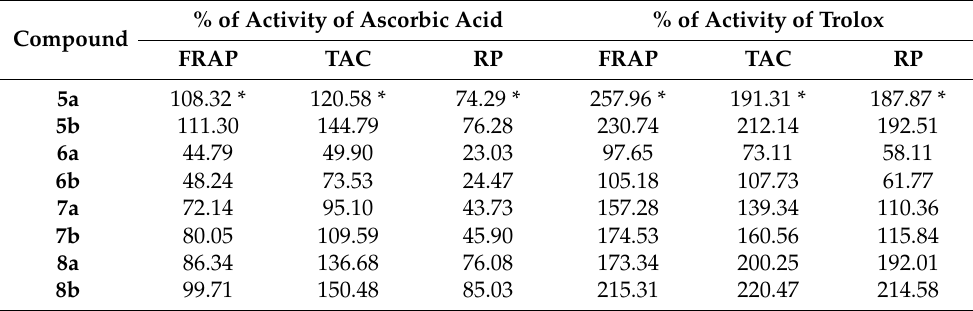
Table 4. Results of the Ferric Reducing Antioxidant Potential (FRAP), Total Antioxidant Capacity (TAC), and Reducing Power (RP) assays, expressed as % activity of ascorbic acid and trolox. % of Activity of Ascorbic Compound